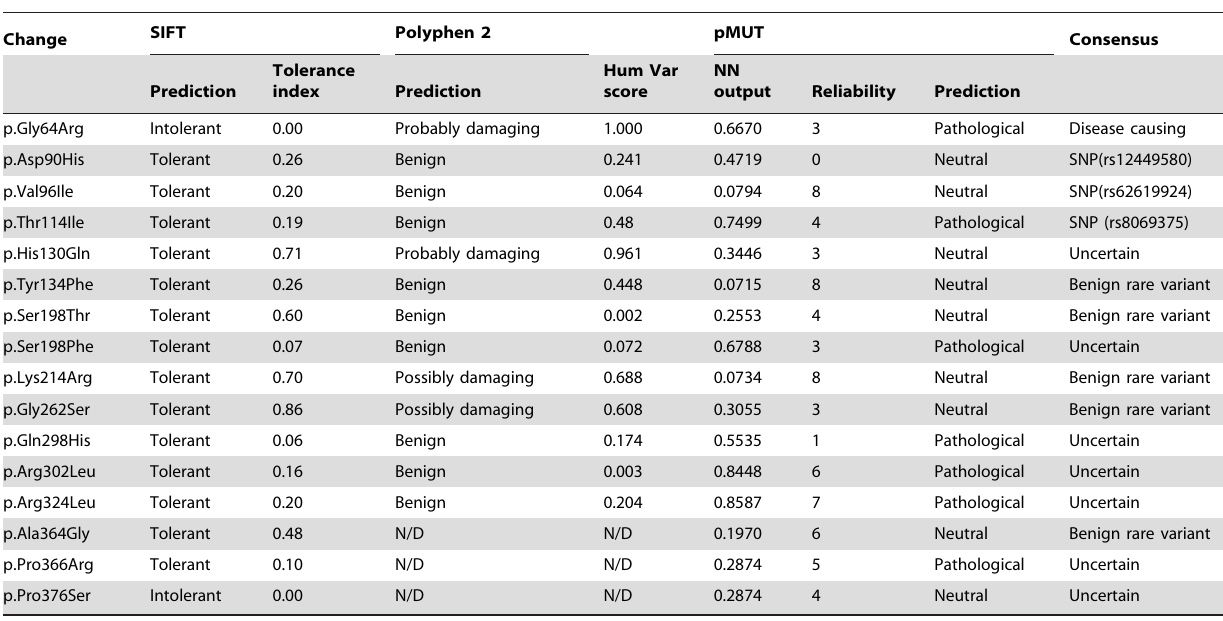
Table 2. In silico analysis of all missense variants identified in AIPL1 in this study.